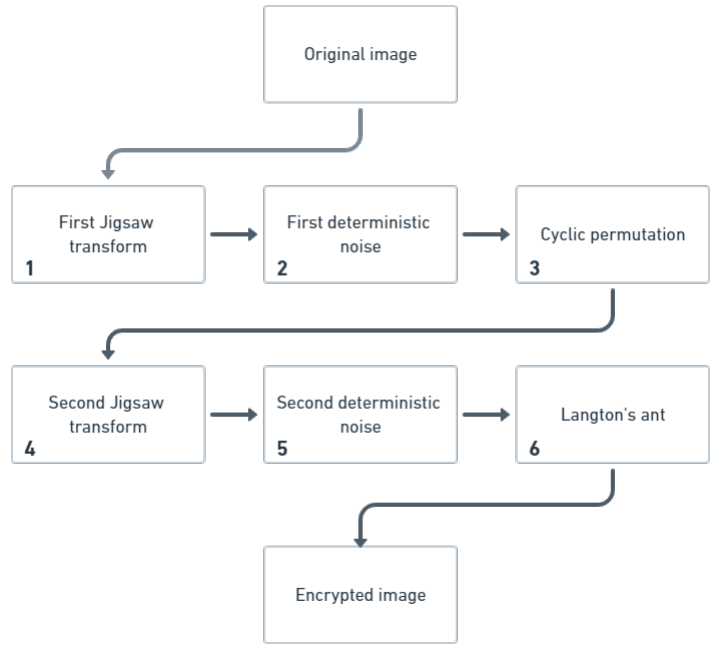
Figure 10. The six steps of the encryption